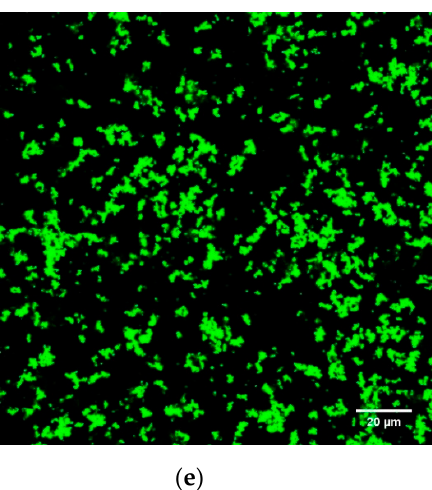
Figure 5. CLSM images of plain ADG 0% ( a ), ADG with 15% black tea infusion ( b ), ADG with 30% black tea infusion ( c ), ADG with 45% black tea infusion ( d ), ADG with 60% black tea infusion ( e ) (day 28). Protein stained by Fast Green FCF appears as green and non-fluorescent areas (dark areas) correspond to the serum pores.